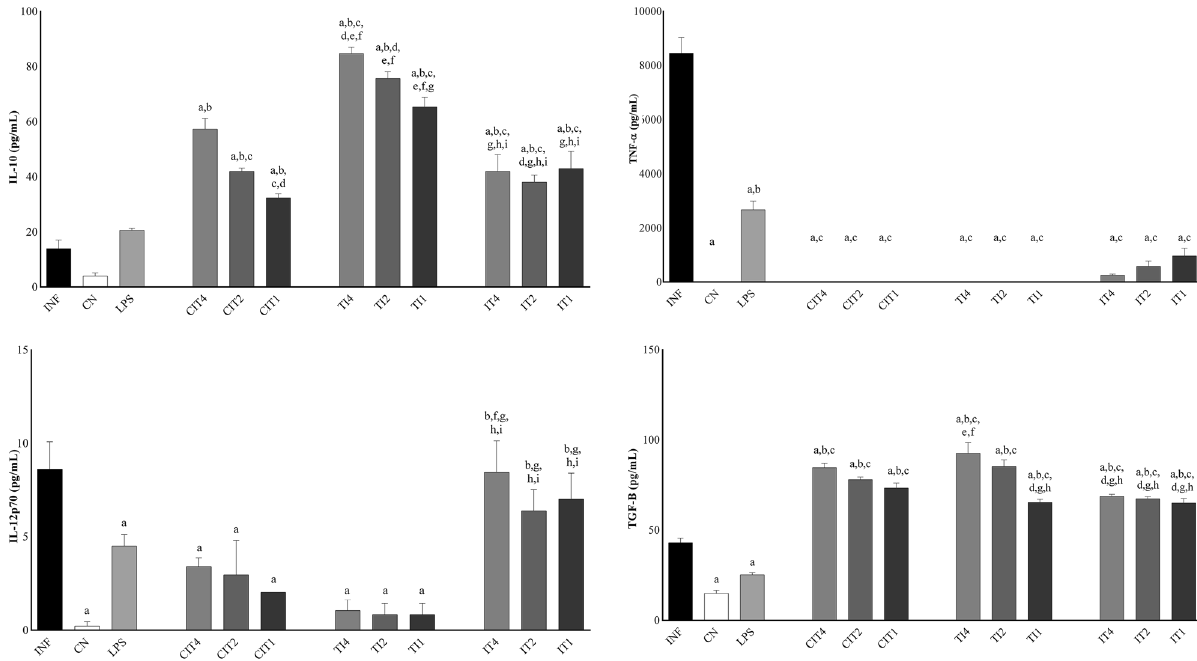
Figure 3. For analysis of cytokines IL-10, IL-12p70, TGF-β, and TNF-α in human monocytes, the following groups were established: infected with isolate 80 (INF), negative control group (CN), groups with citral treatment (CIT) at 4%, 2%, and 1% (CIT4, CIT2, and CIT1), groups treated with citral at 4%, 2%, and 1% and infected (TI4, TI2, and TI1), and infected and treated groups with citral at 4%, 2%, and 1% (IT4, IT2, and IT1). Treatment for 30 min and infection for 6 h. Statistically significant differences ( P < 0.05) compared to the INF control are indicated by letters: ( a ) compared to the negative control: ( b ) compared to LPS: ( c ) compared to CIT4: ( d ) compared to CIT2: ( e ) compared to CIT1: ( f ) compared to TI4: ( g ) compared to TI2: ( h ) compared to TI1: ( i ) compared to IT4: ( j ) Statistical significance (Mann–Whitney One-tailed; GraphPad Prism, IL-10 and IL-23 at the three concentrations, IL-1β at concentrations of 4% and 2%, IL-10 and TGF-β at 2% and 1%, and IL-1β and TGF-β at a concentration of 1%. For the IT groups, a significant difference was observed for IL-1β, IL-10, IL-12p70, IL-23, IFN-γ, and TGF-β compared to most of the other study groups. Gene expression analysis. Gene expression was also evaluated in human monocyte samples from the following groups: infected group (INF), negative control group (CN), treated group (CIT), and treated and infected group (TI). Among the 84 genes analysed, 68 were regulated in groups infected with S. aureus com- pared with the CN group. There were statistical differences between the groups for 29 up-regulated genes related to toll-like receptor genes ( TLR8) , response to bacterial pathogens (CCL2, IL6, LTA, NFKB1) , TLR signalling: TICAM- dependent (MYD88- independent : IRF3, MAP2K4, TRAF6; MYD88 -dependent : NR2C2, TIRAP, TLR8, TRAF6) , downstream pathways and target genes: NFκB pathway ( BTK, LY96, NFKB1, NFKBIA, NFRKB, REL, RELA, TNF, UBE2N ), mammalian stress-activated protein kinases p38 and JNK (JNK/p38) pathway ( ELK1, MAP2K4, IL1B ), Janus kinases/signal transducer and activator of transcription (JAK/STAT) pathway ( CSF2, IL2, IL6 ), interferon regulatory factor pathway (IRF1, IRF3 ), cytokine-mediated signalling pathway ( IL1A, IL1B, IL6, RELA ), regulation of adaptive immunity ( CD86, HSPD1, IL2, TRAF6), adapters and proteins that interact with TLR (BTK, HSPD1, MAP2K4), and EIF2AK2, UBE2N (Fig. 4A). Seventy-four genes were regulated in the treated and infected groups compared to the positive control groups. There were statistical differences between the groups for 31 down-regulated TLR genes ( TLR8 ), response to bacterial pathogens ( FOS, IL12A, IL6, IRAK1, JUN, PTGS2 ), TLR signalling: negative regulation ( SARM1, SIGIRR ), TICAM- dependent (MYD88 -independent : IRF3, TBK1, TRAF6, TICAM2 ), MYD88- dependent ( TLR8, TRAF6 ), downstream pathways and target genes: NFκB pathway ( CASP8, IKBKB, LY96, NFKB1, UBE2N ), JNK/ p38 pathway ( FOS ), JAK/STAT pathway ( CSF2, CSF3 ), interferon regulatory factor pathway ( IFNA1, IRF1, IRF3 ), cytokine-mediated signalling pathway ( IL1A, IRAK1, SIGIRR ), regulation of adaptive immunity ( CD86, HSPD1, TRAF6 ), adapters and proteins interacting with TLR (HSPD1, MYD88, RIPK2, SARM1, TICAM2), and EIF2AK2, IRAK1, IRAK4, PPARA, PRKRA, UBE2N (Fig. 4B). Twelve genes were regulated in the treated and infected groups compared to the negative control group. There were statistical differences involving four down-regulated genes: FASLG , positive T regulatory cells ( FOXP3 ), IL-23 , and HLA-A , and there were statistical differences between nine upregulated genes: interferon regulatory factor pathway ( IFNB1, IFNG, IFNGR1 ), JAK2 , and regulated TLR genes ( TLR1, TLR4 , and TLR8 ) (Fig. 4C). Two genes (response to bacterial pathogens TNFRSF1A and NFκB pathway ( NFKB1 )) were downregulated in the treated group compared with the CN group (Fig. 4D).